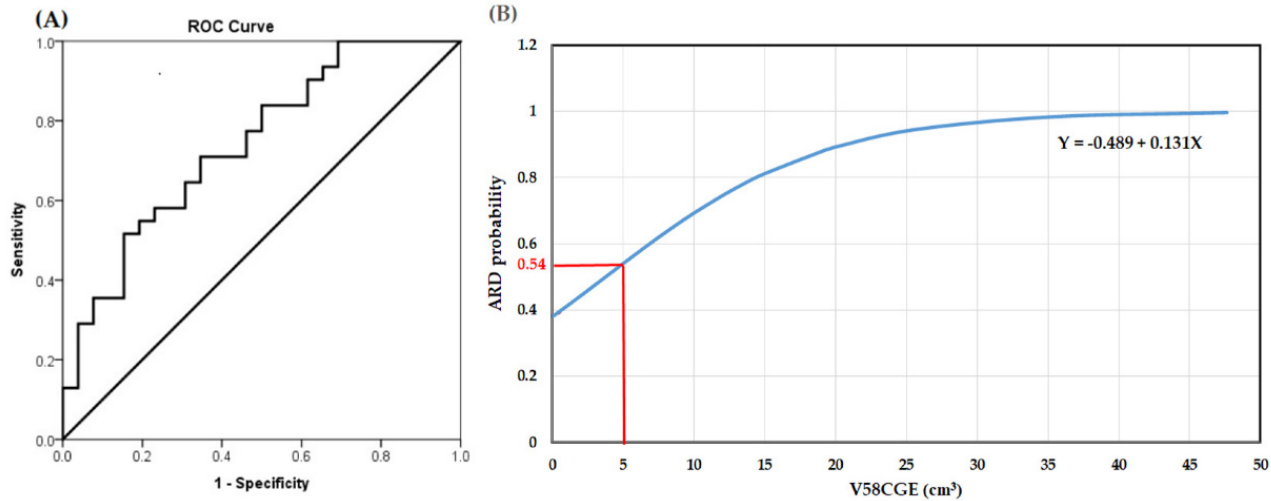
Figure 3. ( A ). Receiver operating characteristic (ROC) curves from the V58CGE model in prediction of grade 2 and 3 acute radiation dermatitis (ARD); ( B ). Logistic plot of the relationship between V58CGE and the probability of developing grade 2 and 3 ARD.